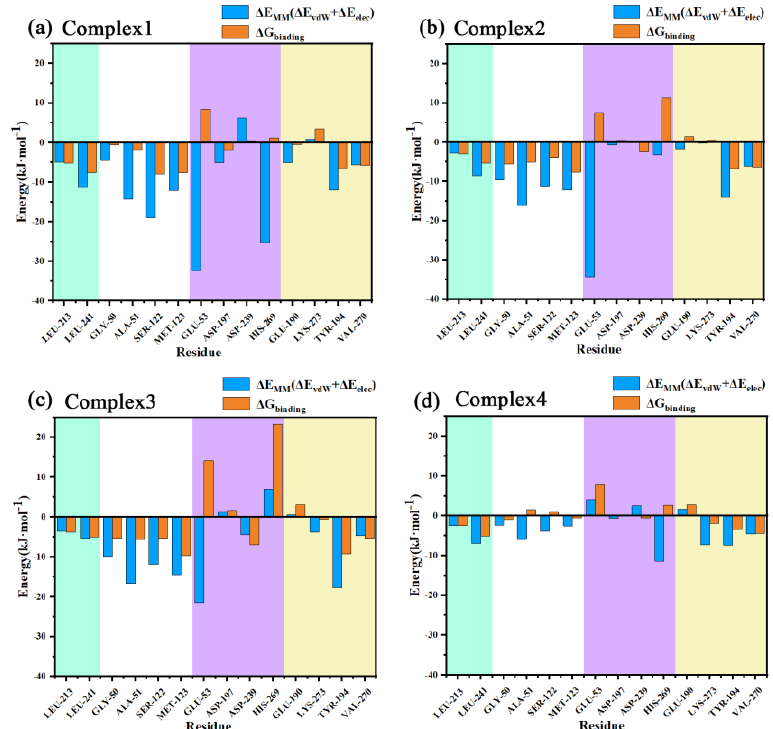
Figure 11. ( a – d ) Decomposition energies of the important residues in the complexes 1–4 are shown from left to right in each figure for residues near the head benzene ring (green areas), near the head carbonyl oxygen (white areas), near the tail amide bond (purple areas), and near the tail benzene ring (yellow